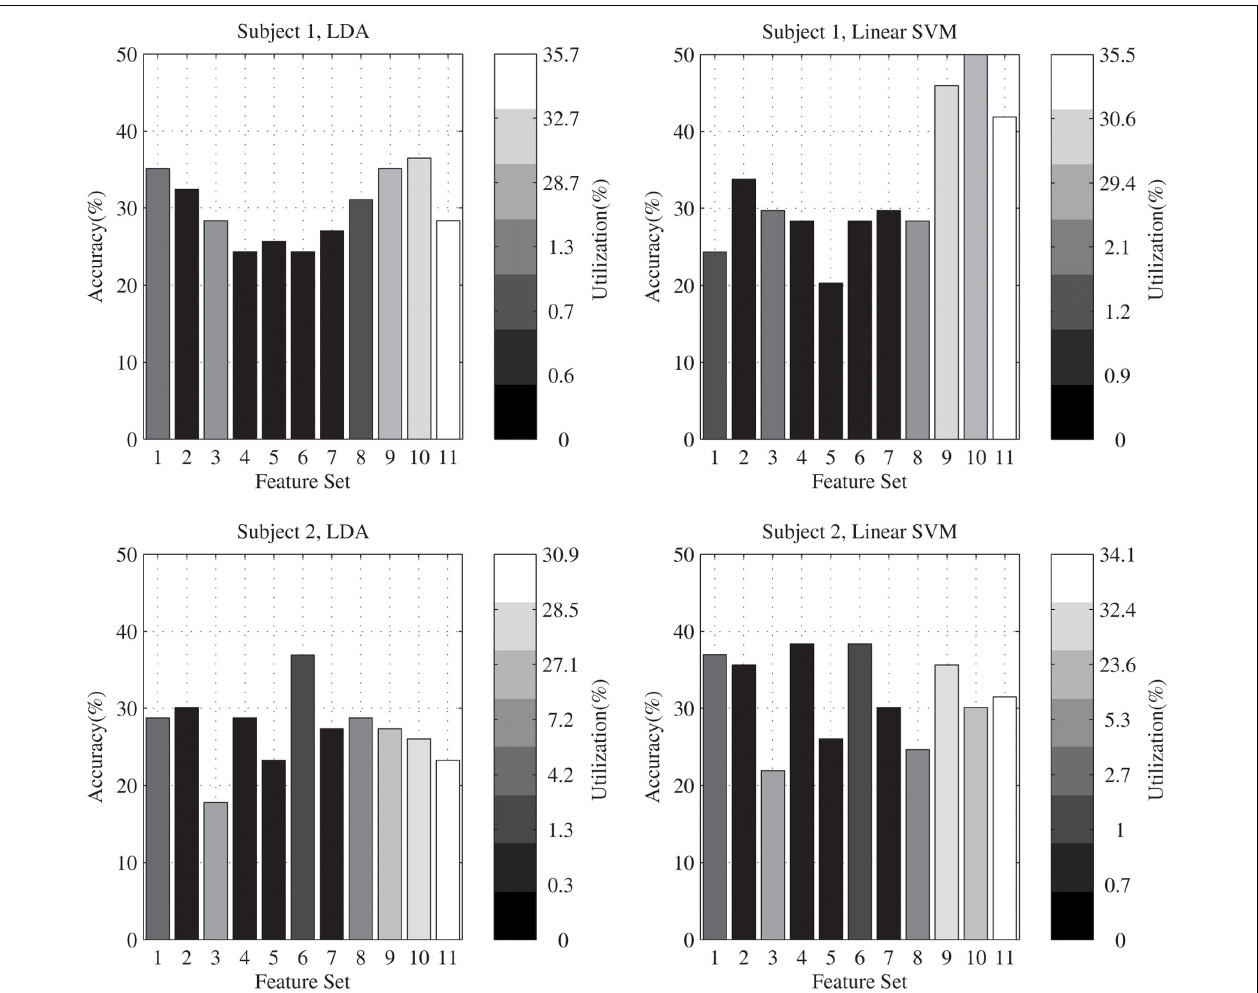
FIGURE 3 | Comparing the percent of utilization of each feature set with the accuracies which were calculated for